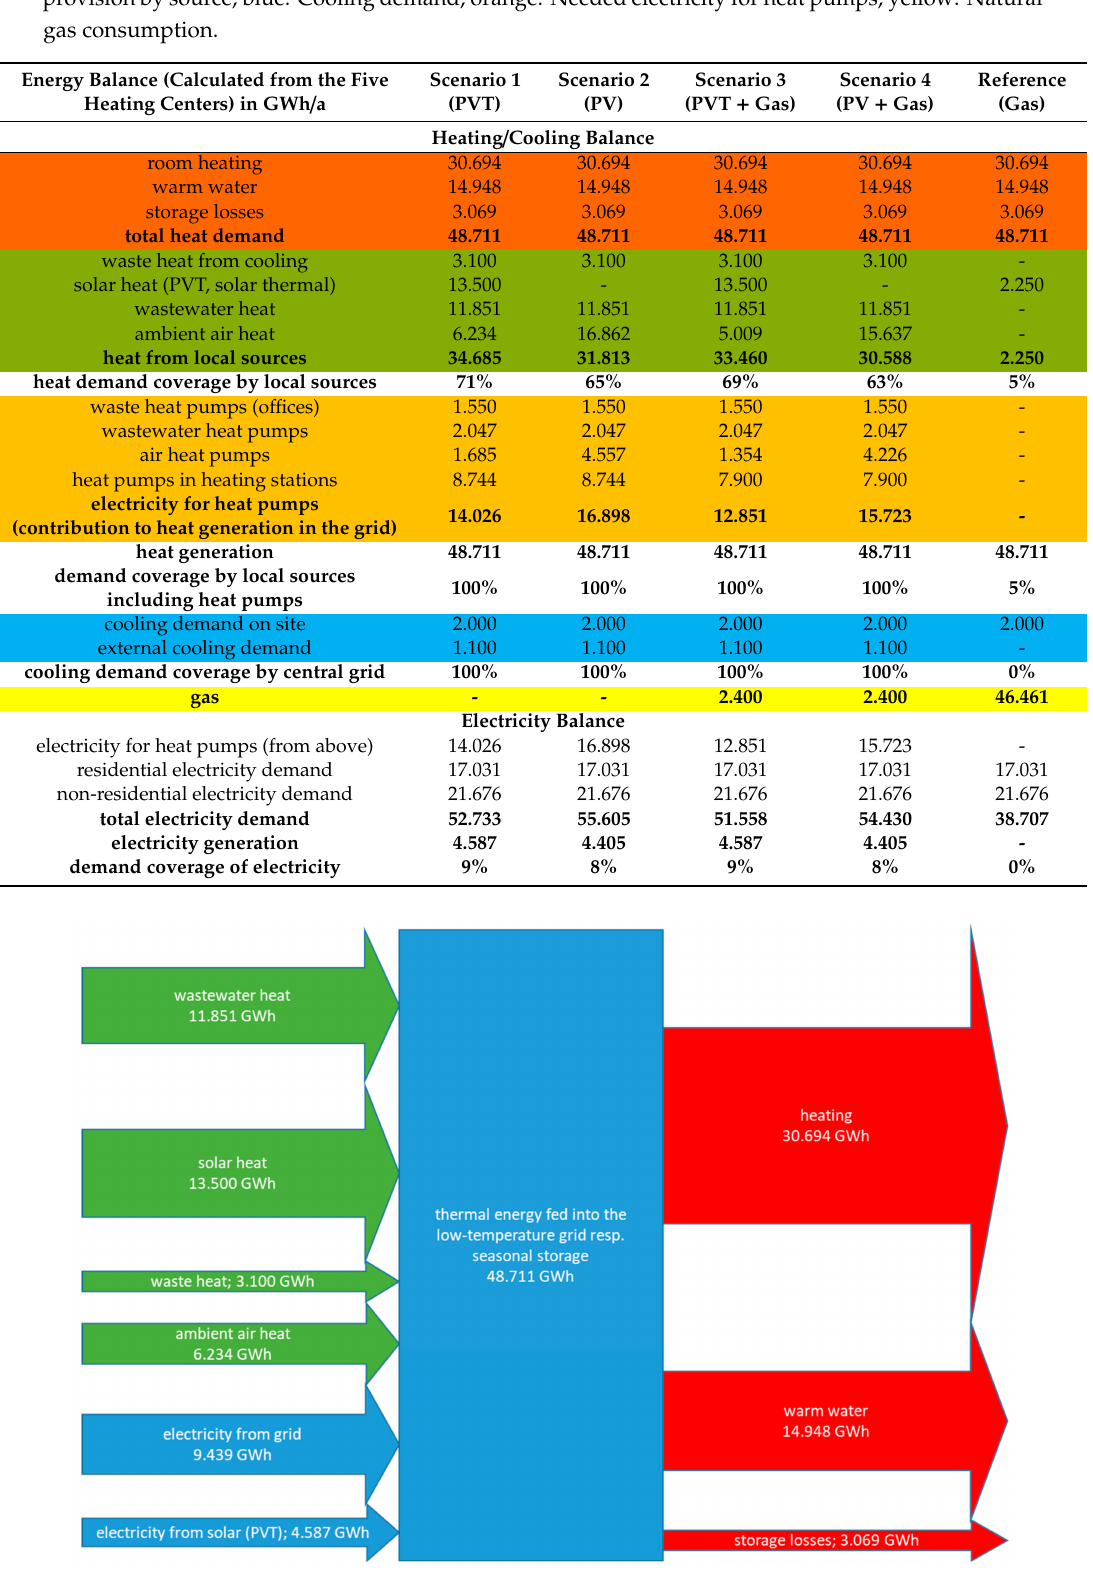
Figure 6. Graphical illustration of the thermal energy flows of Scenario 1 during 1